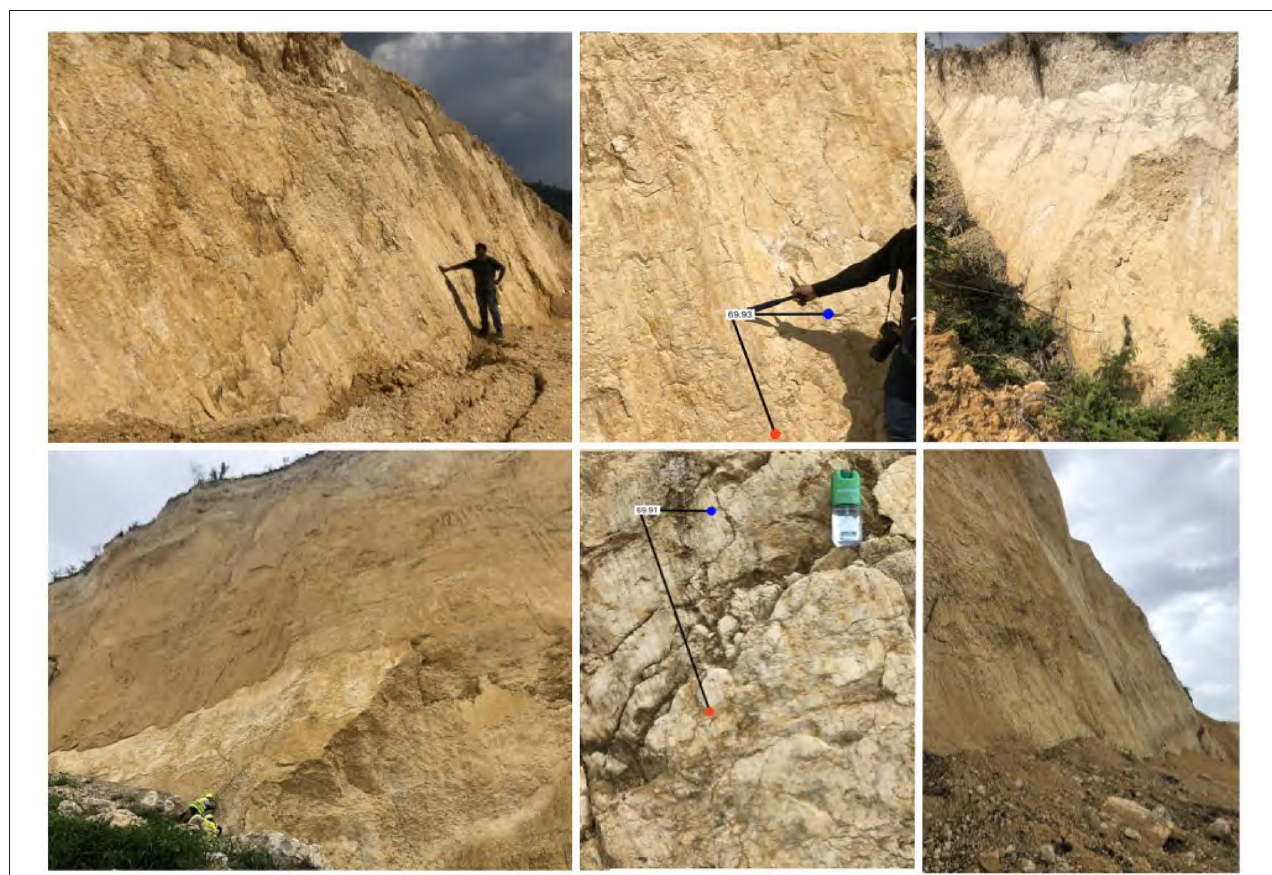
FIGURE 9 | A N66 ◦ E fault plane at the landslide head showing slickensides and slickenlines with a 69.9 ◦ rake angle. Oblique slip movement is suggested by the direction and orientation of the slickensides.